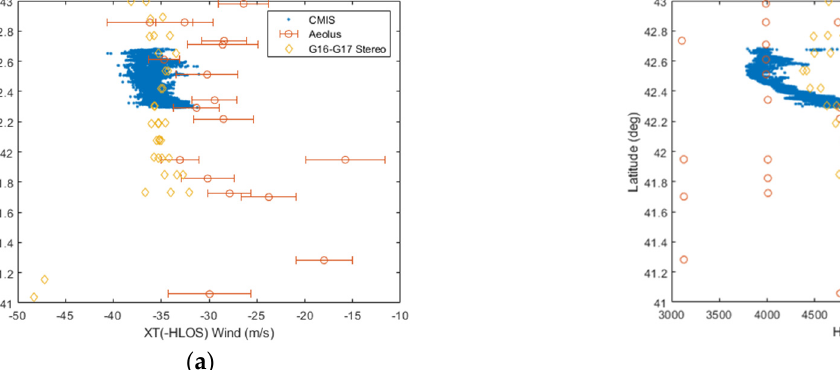
Figure 18. Comparison between Aeolus, G16-G17 stereo, and CMIS stereo for ( a ) XT winds and ( b ) stereo heights over Michigan on 8 February 2021. ( b ) stereo heights over Michigan on 8 February